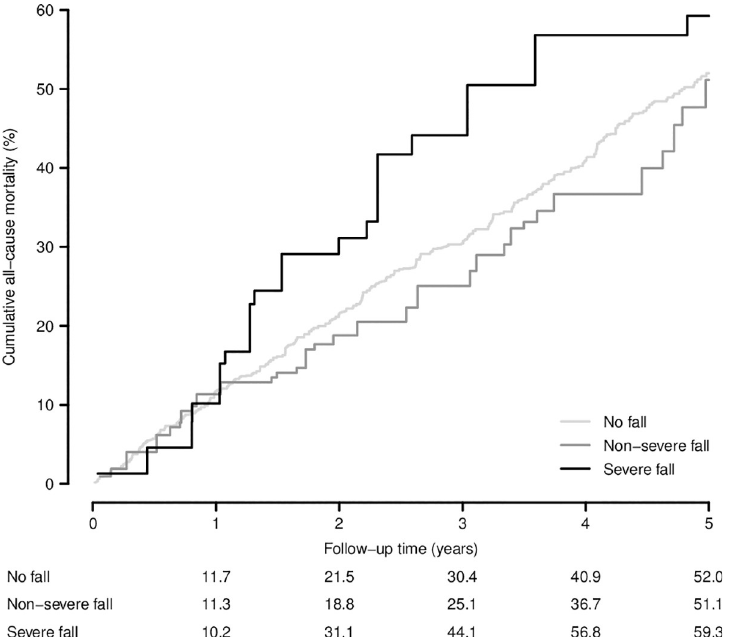
Fig 1. Adjusted cumulative all-cause mortality by severity of fall among nursing home residents in Madrid, Spain. Non-parametric cumulative mortality curves were obtained as the complement of the baseline survival functions from a Cox model stratified by severity of fall (no, non-severe, or severe), adjusted to the overall weighted percentages of baseline age (65–74, 75–79, 80–84, 85–89, or � 90 years), sex (women or men), type of facility (public, subsidized, or private), dementia (yes or no), number of chronic conditions other than dementia (0–1, 2–3, or � 4), use of antidepressants (yes or no), number of prescribed medications other than antidepressants (0–2, 3–4, or � 5), urinary incontinence (no, mild, or severe) and functional dependency excluding (in)continence (independent, mild/moderate, or severe/total), and accounting for the stratified cluster sampling and the different selection probabilities.